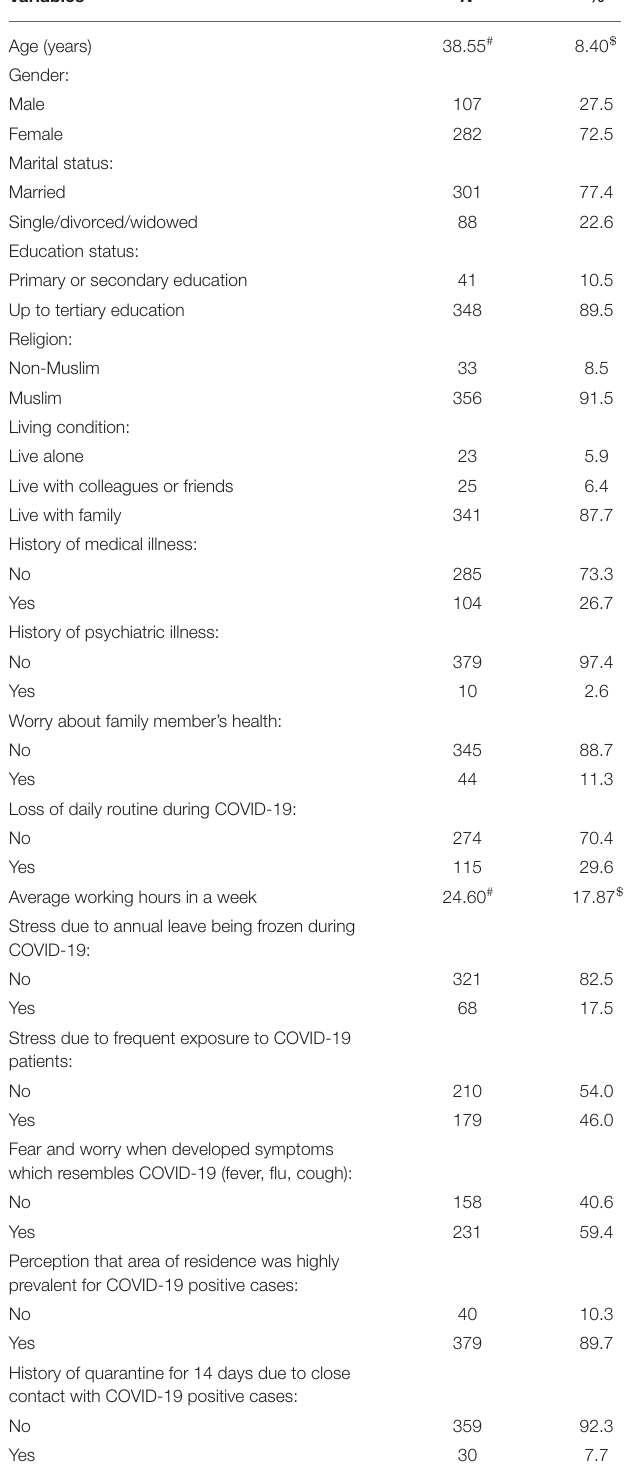
TABLE 1 | Demographic, personal, clinical characteristics, COVID-19 related factors, psychological characteristics, perceived social support, and quality of life of the